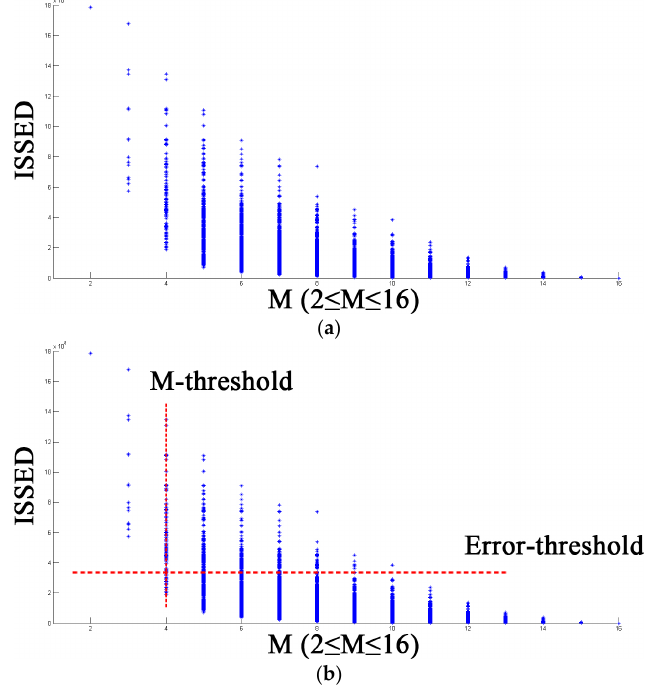
Figure 2. ( a ) Enumeration of all compression schemas of a trajectory that contains 16 points. Each point in the graph represents a simplified track with M points and Y-axis shows the ISSED error. ( b ) Min-# problem is to find the minimum value of M below the error threshold, which is four below the horizontal red line. Min- ε problem is to find the minimum ISSED under the M-threshold, which is the lowest point along the vertical red line.